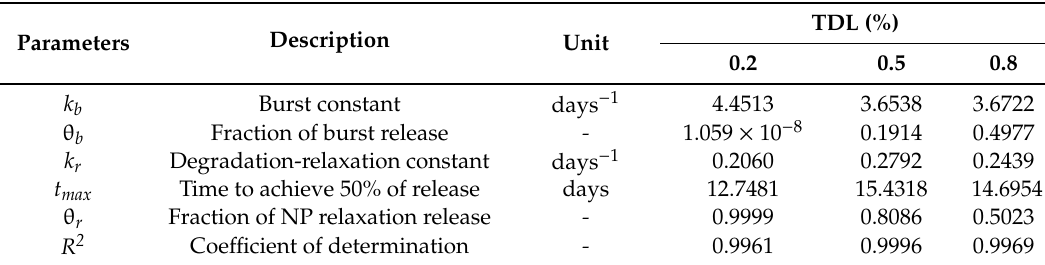
Table 2. Parameters of plasmid pVAX1-NH36 release from pDNA-NP. The parameters were determined and used in the mathematical development of the release